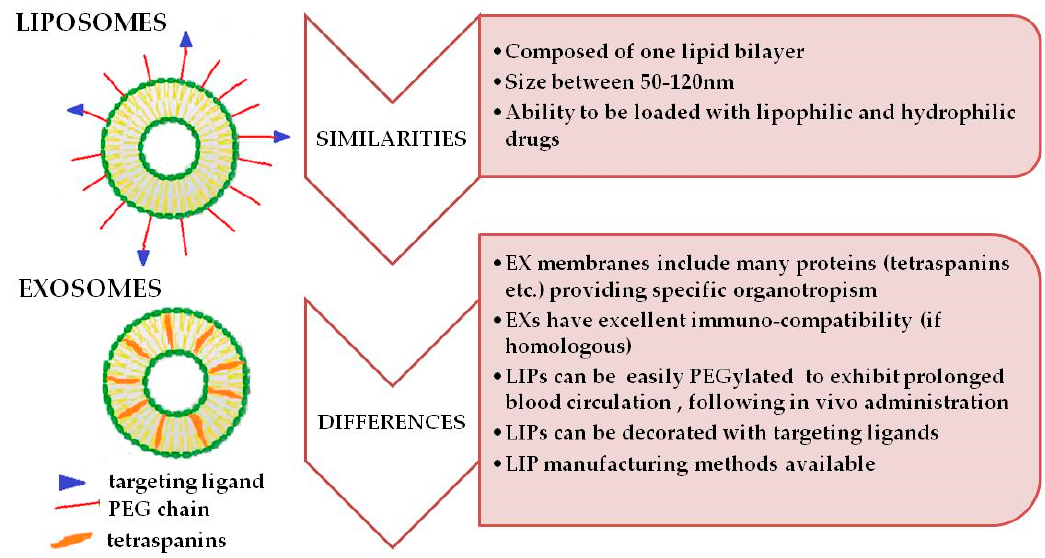
Figure 2. The basic structural characteristics, as well as the main similarities and differences of liposomes and exosomes are presented.